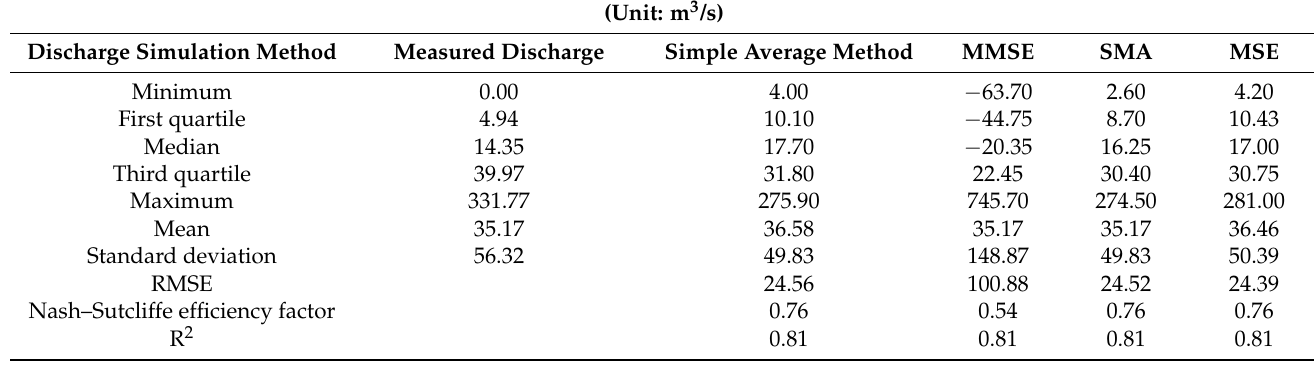
Table 9. Comparison of the distribution and statistics of the runoff blending results for the Deoksong SHP plant. (Unit: (cid:1813) (cid:2780) /(cid:1819))